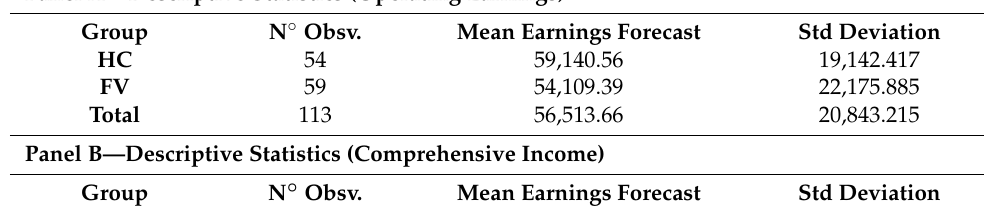
Table 2. Analysis of Earnings Forecast. Panel A—Descriptive Statistics (Operating